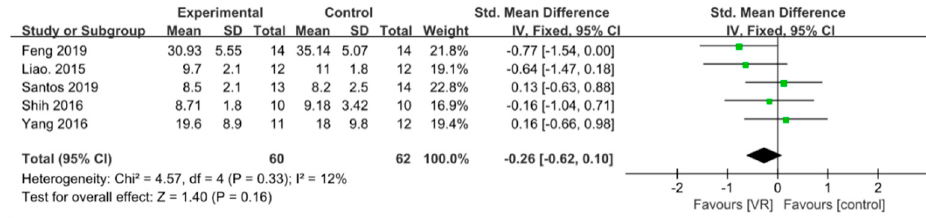
Figure 5. Meta-analysis results for Timed Up and Go (TUG) .